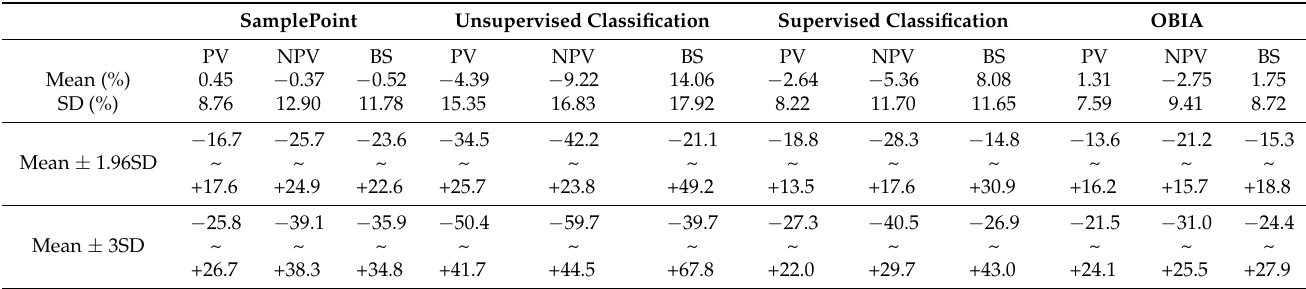
Figure 5. Bland-Altman plot of the difference between SamplePoint estimation and in situ assessment for PV, NPV, and BS fraction covers. Refer to the left panel for threshold values. The red dotted line is the regression between the two- method mean and the two-method difference.